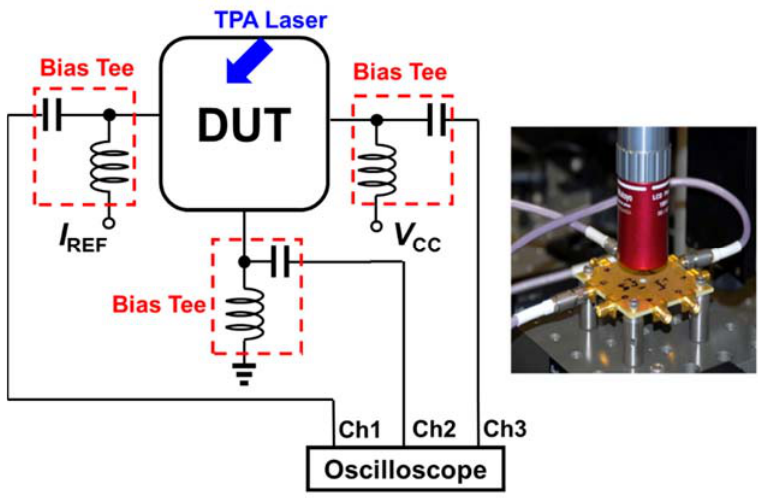
Figure 3. Diagram of the experimental measurement configuration and a photograph of the actual setup.